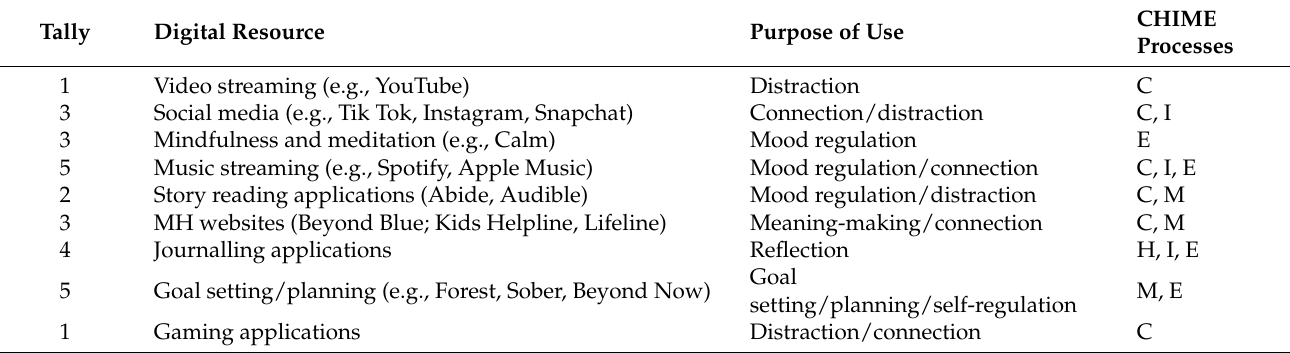
Table 3. Tally of digital resources, purpose of use for youths, and relevance to CHIME.